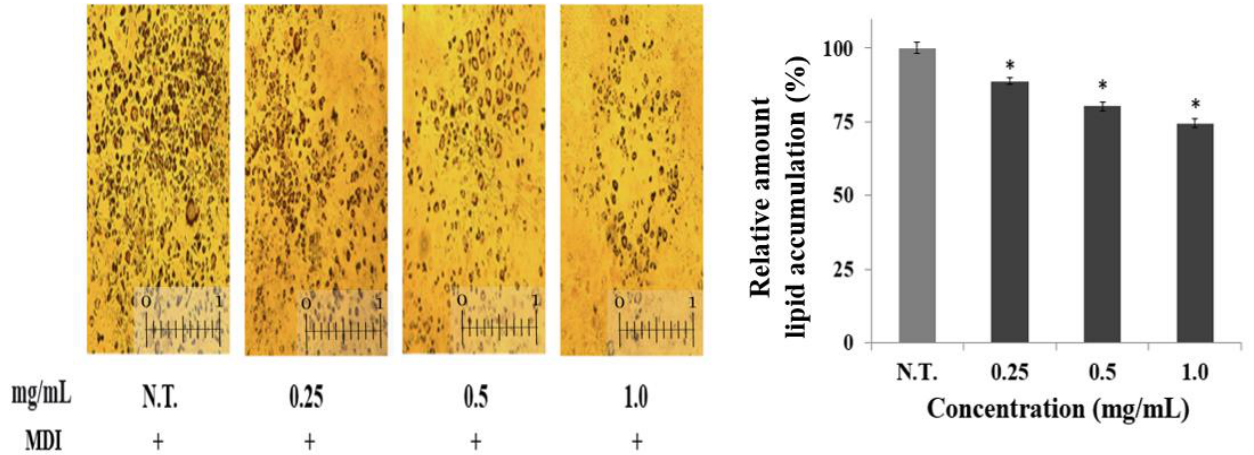
Figure 2. Effect of CGE on the lipid accumulation in adipocytes. Lipid droplets in adipocytes were fixed and stained with oil red O and were observed under a microscope of 64 magnification. Bar graphs represent the relative amounts of accumulated lipid based on untreated samples in adipocytes after being treated with CGE (0.0~1.0 mg/mL). Bars marked with asterisks are significantly different from the control (* p < 0.05).